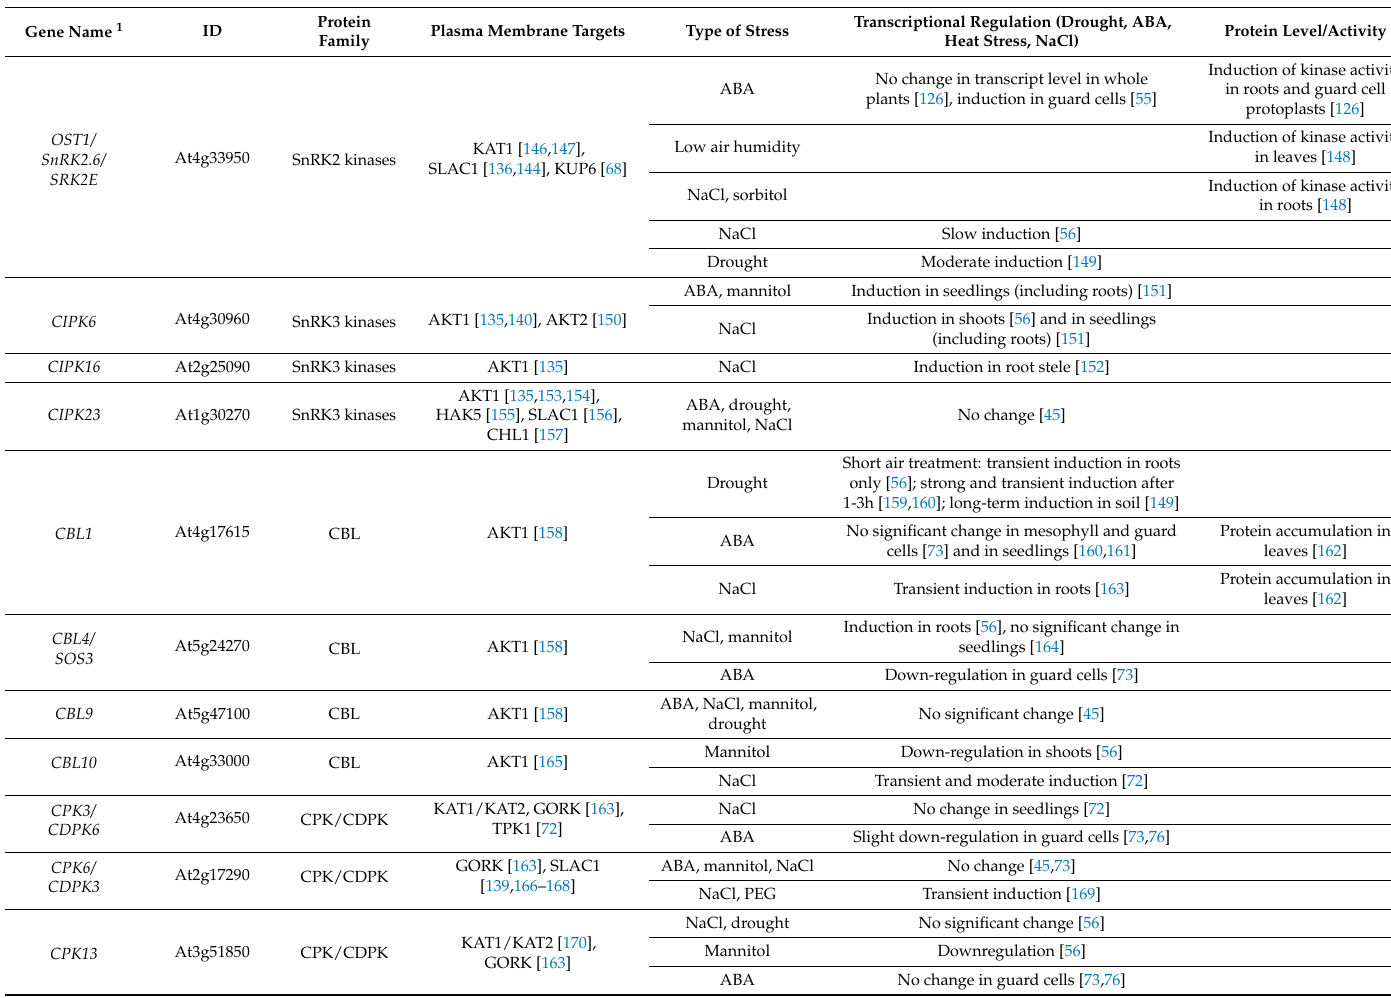
Table 2. Regulatory partners of plant K + transport systems, their targets among K + and mineral anion transport systems, and their regulations in response to ionic and osmotic